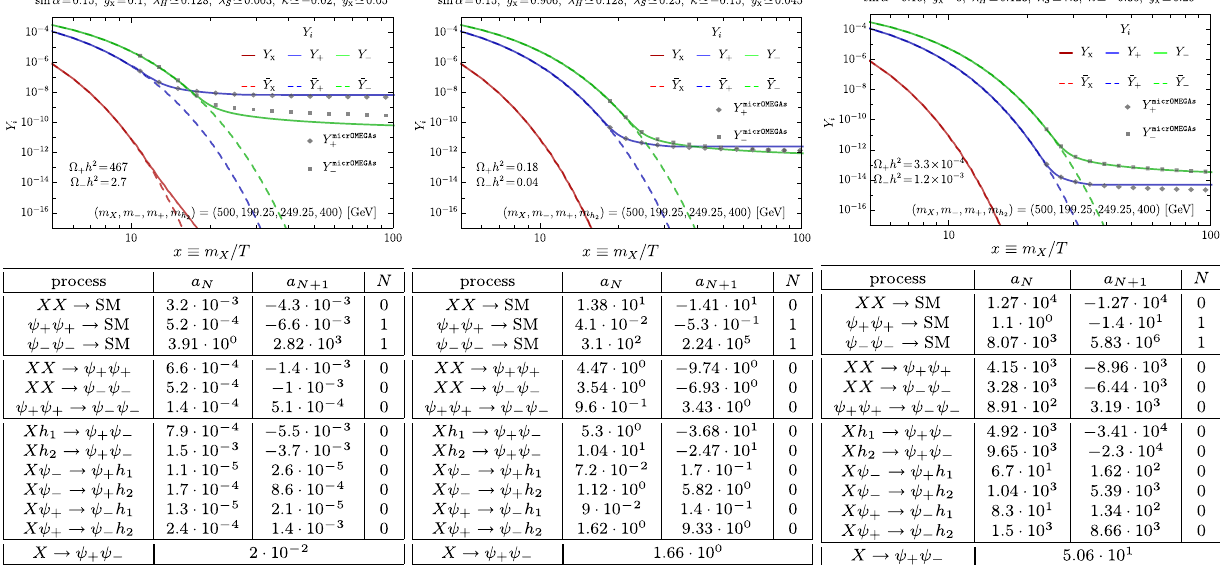
Fig. 9 Solutions of the Boltzmann equations for three sample points fromthe2CDMcasewhere ψ − and ψ + arestableareshownintheupper panels. The left, middle and right plots are for the values of parameter g x = 0 . 1 , 0 . 5 and 5, respectively. The values of other parameters are shown in the legends of plots and other details are same as in Fig. 7.